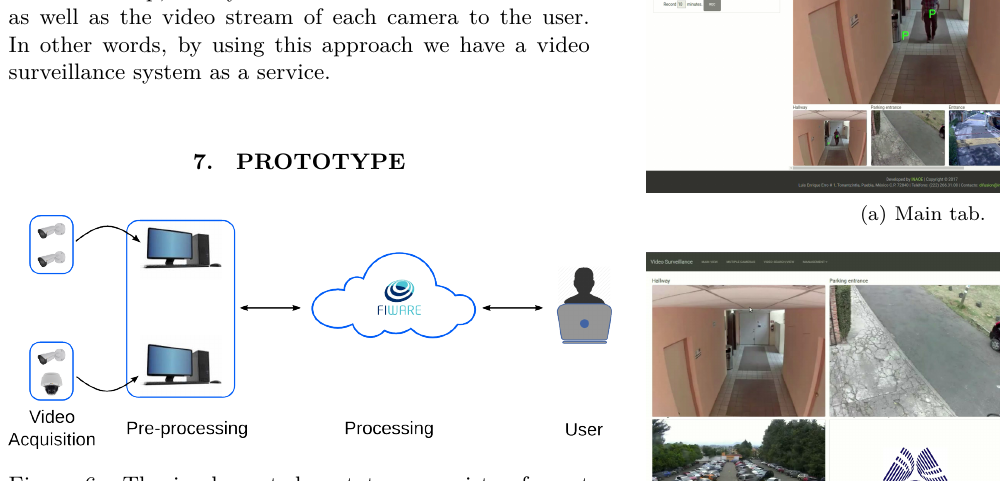
Figure 6. The implemented prototype consists of a set of cameras connected to the network, a couple of desk- top computers for pre-processing and a processing system implemented on FIWARE.